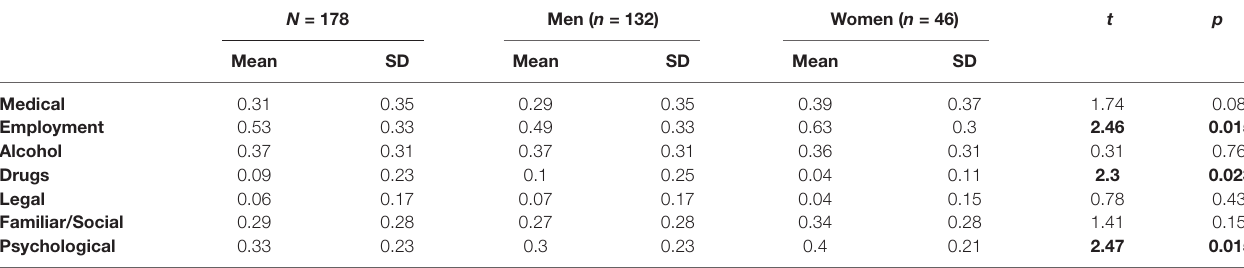
TABLE 3 | EuropASI subareas in the evaluation of the severity of addiction.